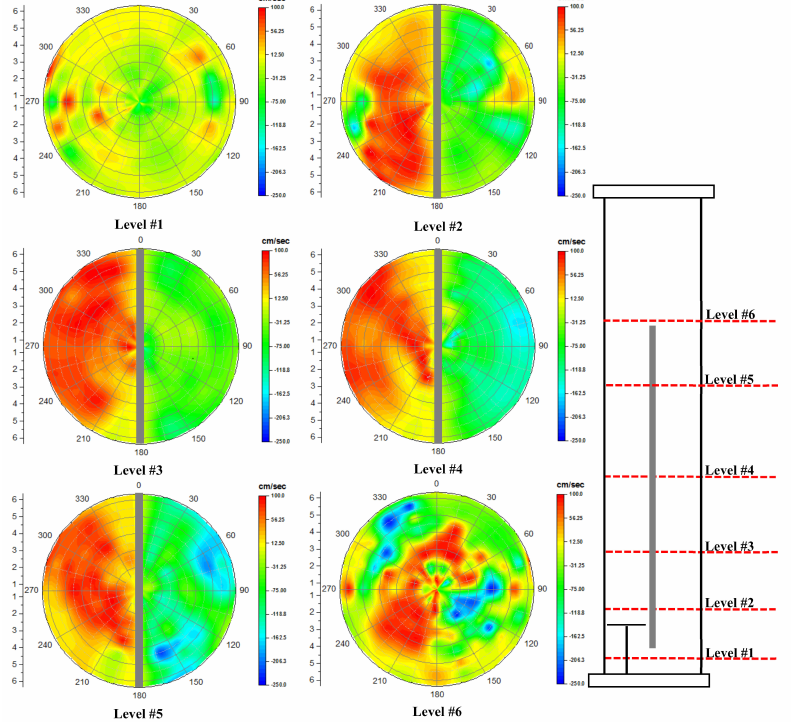
Figure 13. Cross-sectional distributions of axial liquid velocity at different heights of split airlift reactor operated under gas velocity of 2